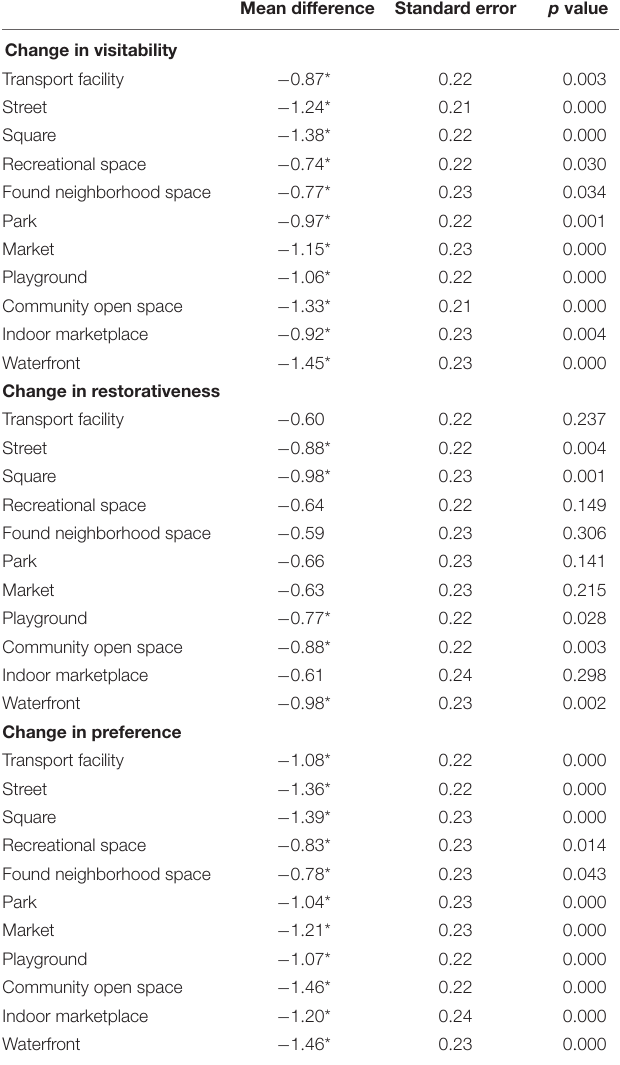
TABLE 6 | Data from Study 1: Tukey’s HSD post hoc tests for comparing memorial against other space types in terms of the effects of street performance. Mean difference Standard error p